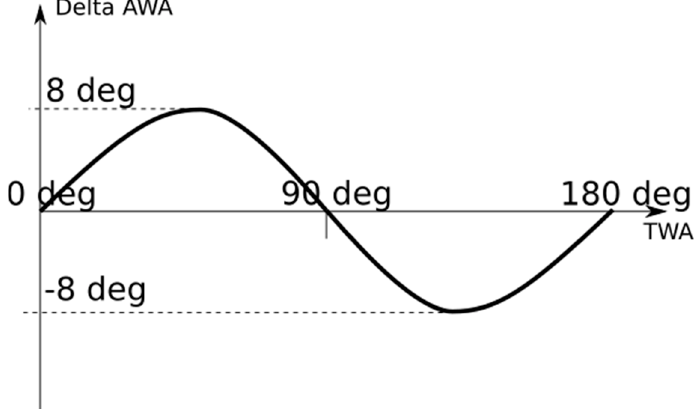
Figure 10. Change in AWA due to deck–sail interaction, over TWA.